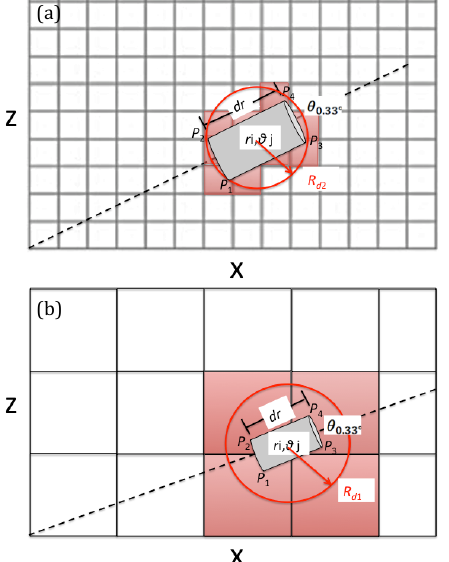
Fig. 3. Vertical cross section of radar resolution volume with fixed azimuth. Identified are the beam width ( θ 3dB ) , the pulse length (dr), the center of the radar volume in polar coordinates ( r i, θ j ) , the edges of radar volume in polar coordinates ( P 1 − 4 ) , the radius of influence ( R d 1 and R d 2 ) and the influenced grid cells (shaded red). (a) repre- sents cases where the radar observation area is larger than the grid cells and (b) represents cases where the radar observation area is smaller than the grid cells.